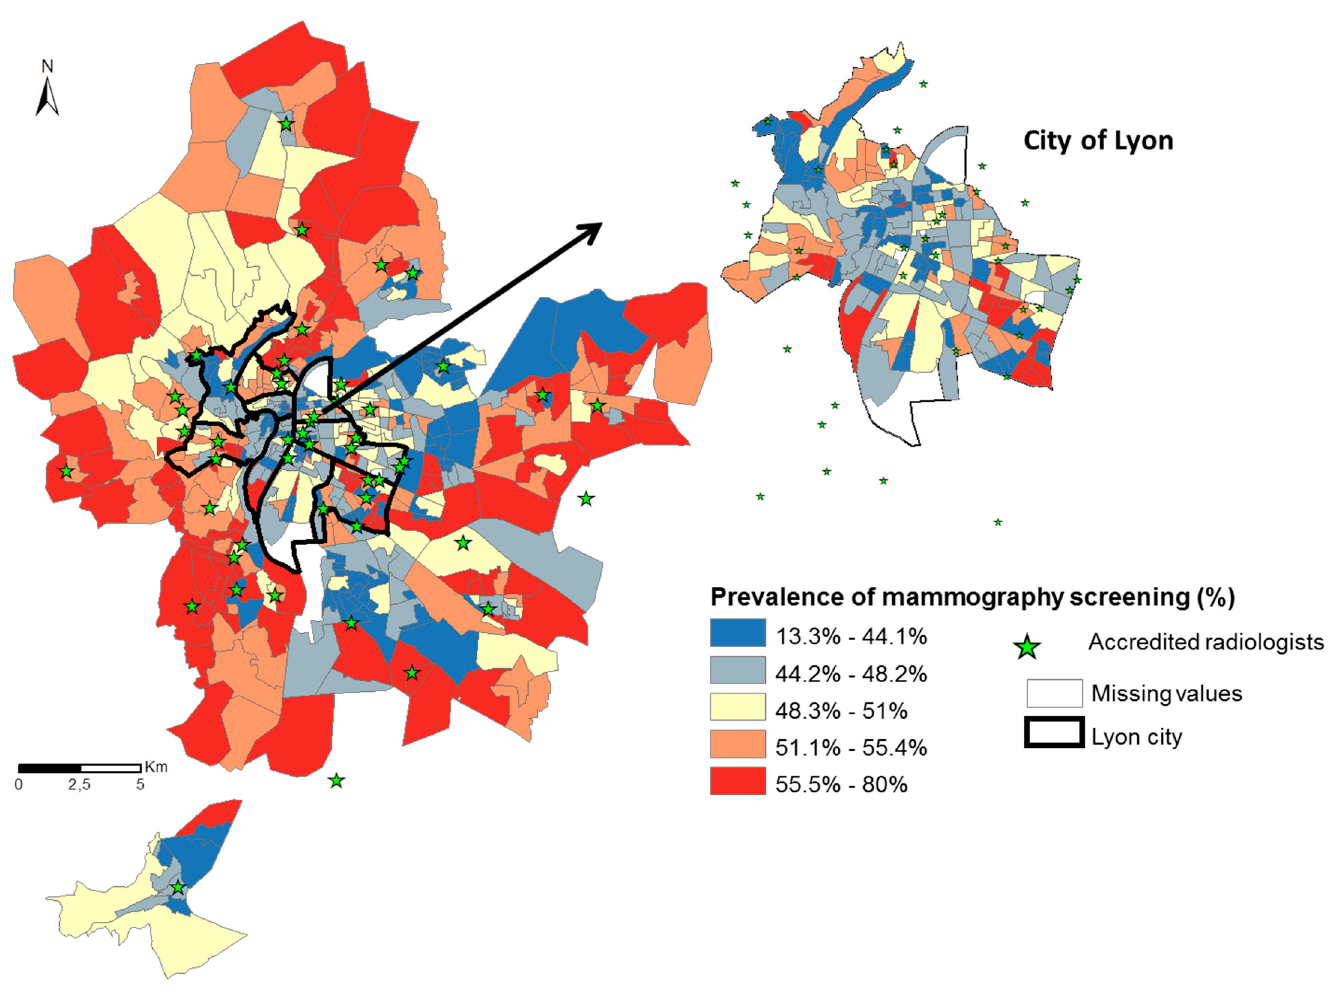
Figure 1. Spatial distribution of the prevalence of mammography screening and the location of accredited radiologists in 2015–2016, Lyon MA.